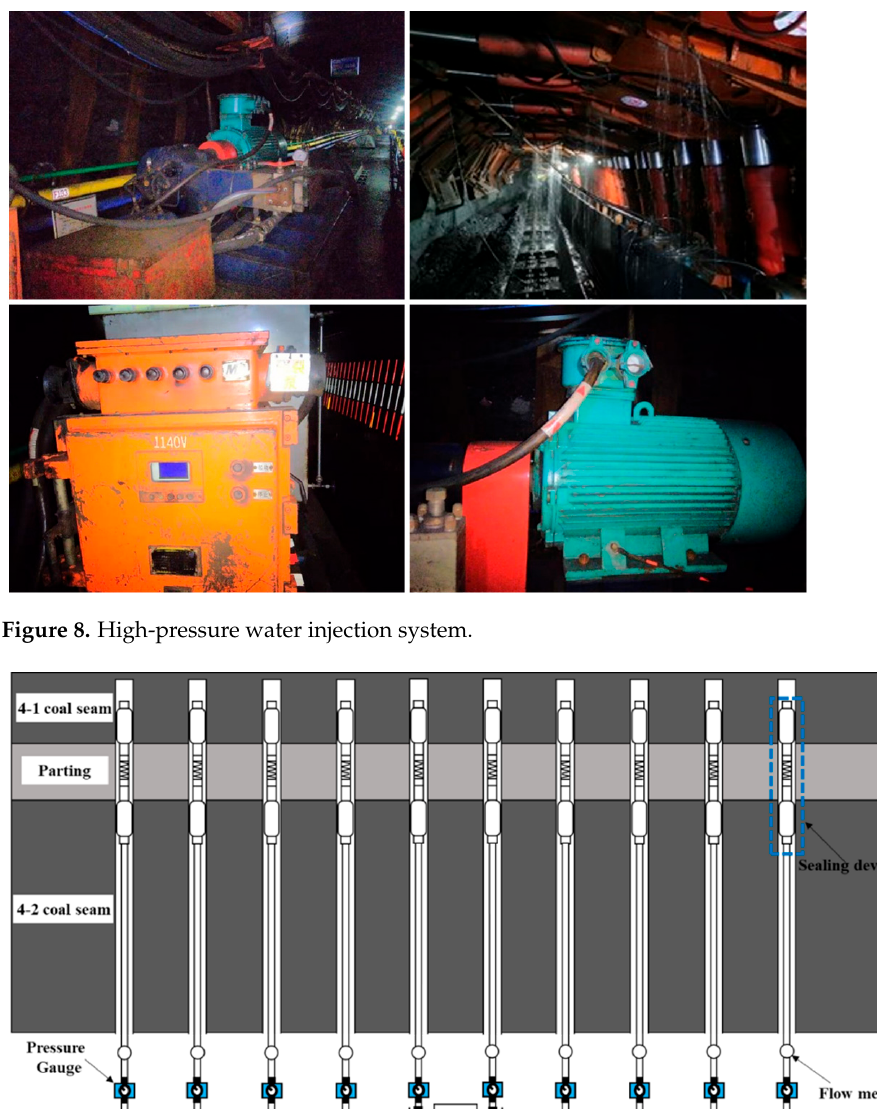
Figure 8. High ‐ pressure water injection system.